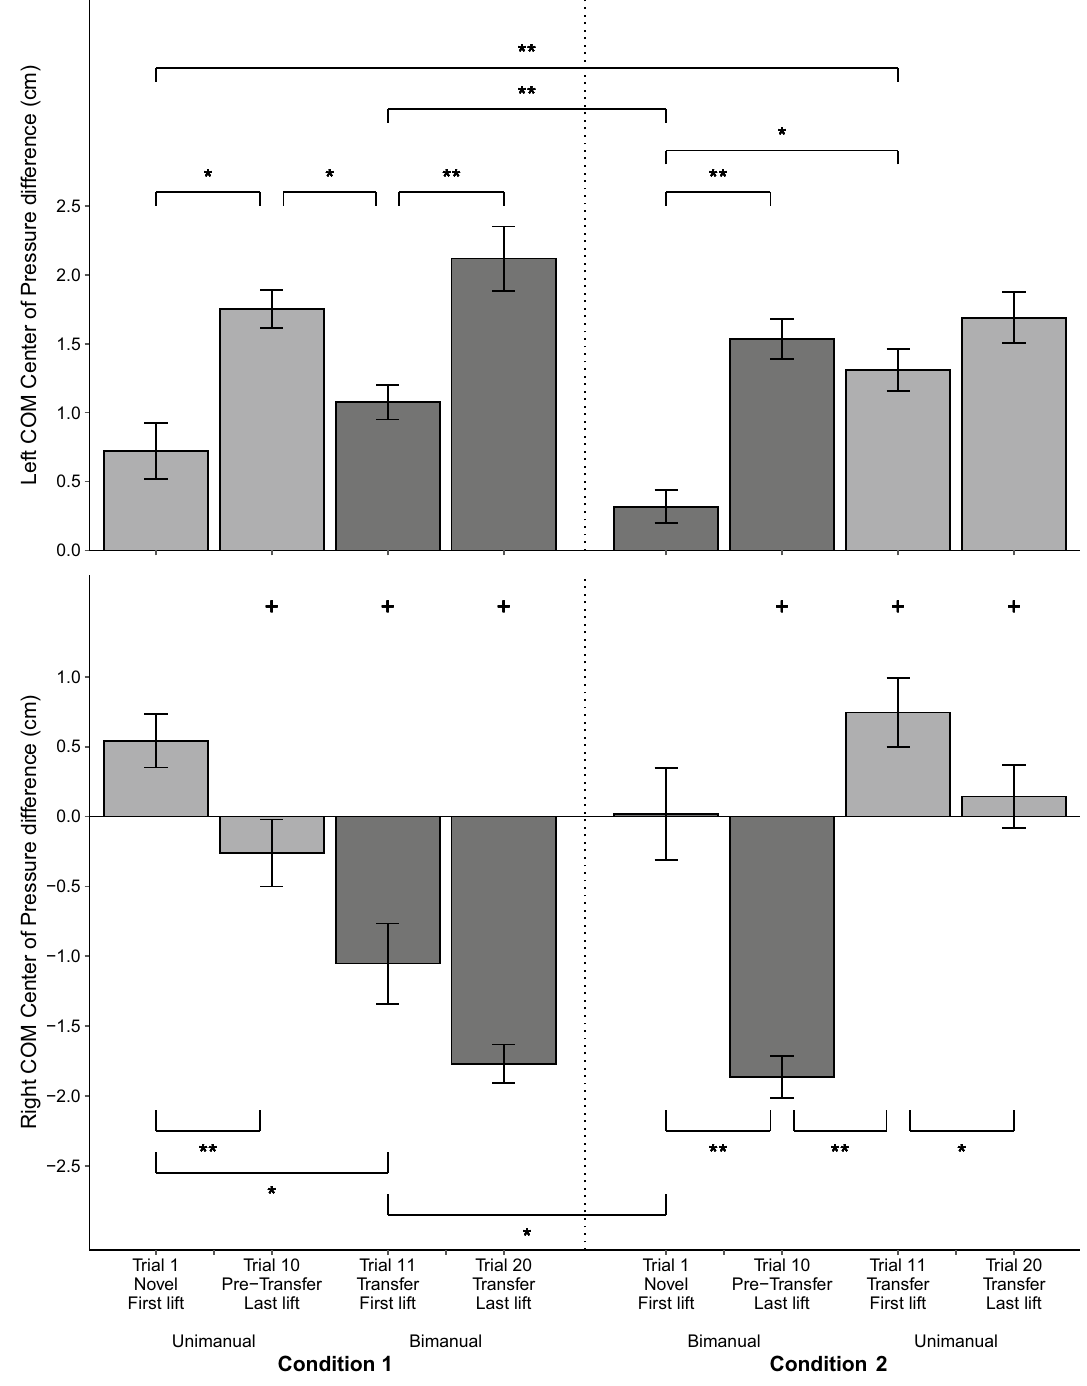
Figure 5. Results for Center of Pressure difference (COP diff ) across all conditions. Average COP diff for the left COM (top panel) and right COM (bottom panel) for the novel first trial, pre-transfer trial 10, transfer trial 11, and trial 20 (± s.e.m). Light grey bar indicates COP diff for the right-hand unimanual trials. Dark grey bar indicates COP diff for the bimanual trials. Error bars indicate the standard error of the mean. The vertical line separates condition 1 (left panel) from condition 2 (right panel). * p < .05, ** p < .001, + p < .05 between the left and right